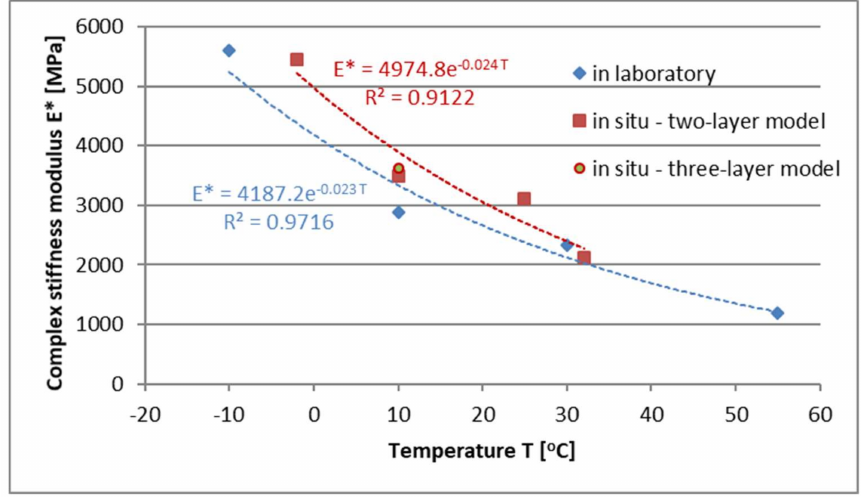
Figure 15. Values of modules in the laboratory and in